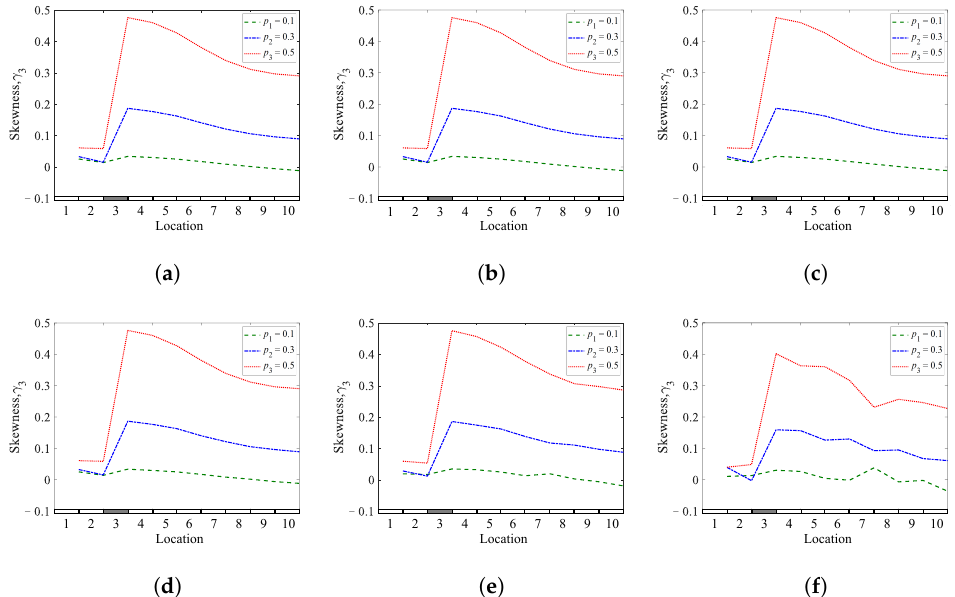
Figure 35. The effect of noise levels on skewness coefficients of a cantilever beam: ( a ) Noise-free; ( b ) SNR = 85 dB; ( c ) SNR = 65 dB; ( d ) SNR = 45 dB; ( e ) SNR = 25 dB; ( f ) SNR = 10 dB.